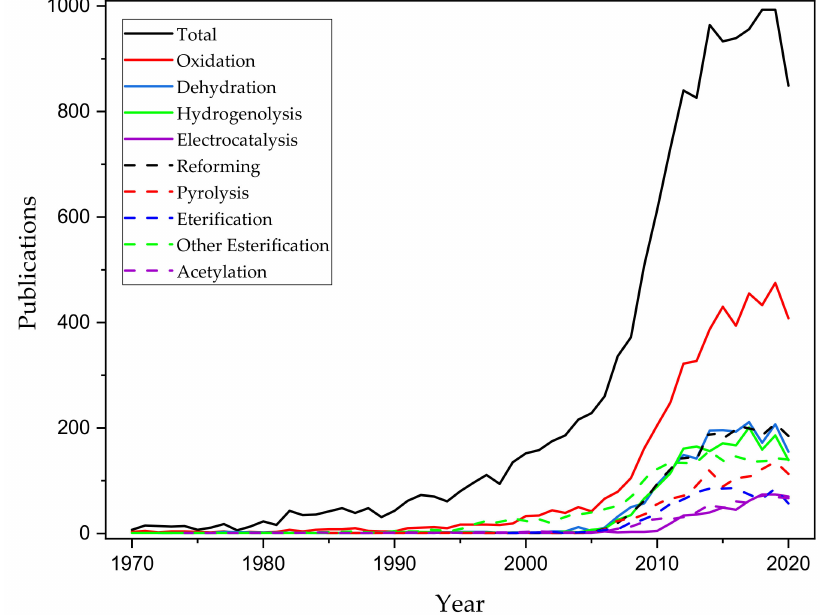
Figure 1. Evolution of the annual number of publications on the catalytic valorization of glycerol per process. Source: Scopus ® (23rd September